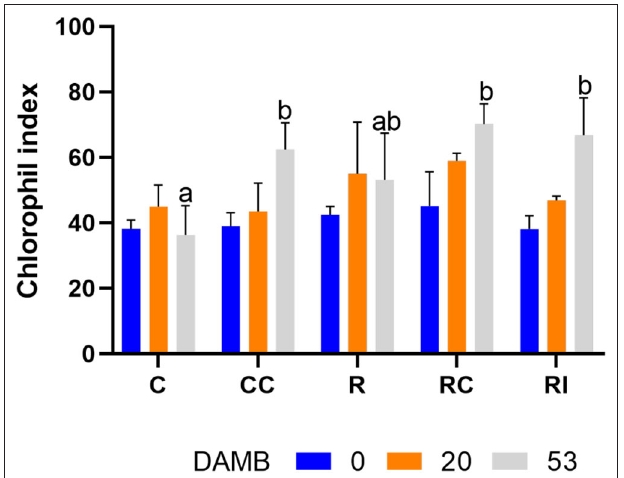
FIGURE 3 | Effect of the soil management method on the chlorophyll index determined by a SPAD-502m on kiwifruit plants at different days after mid bloom (DAMB). C, Control; CC, Control + Compost; R, Ridged; RC, Ridged + Compost; RI, Ridged + Inoculum. Different letters mean significant differences ( p < 0.05).